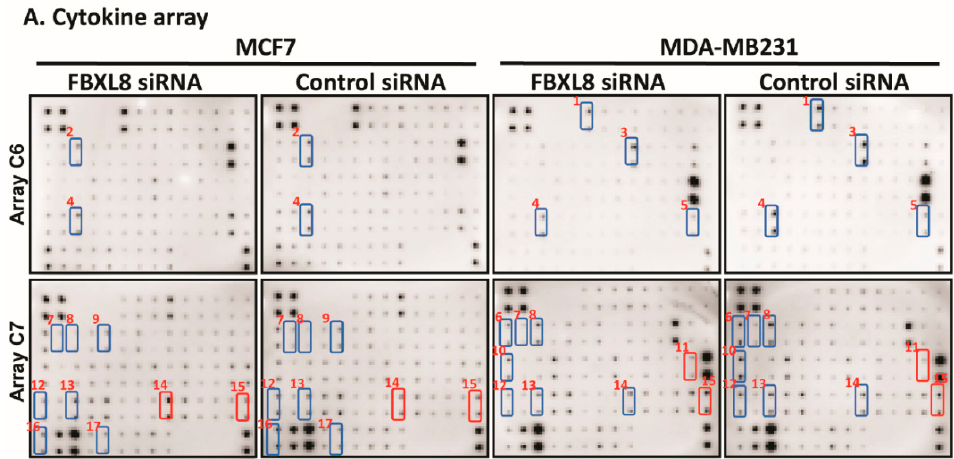
Figure 5. Cont Figure 5 . Cont.